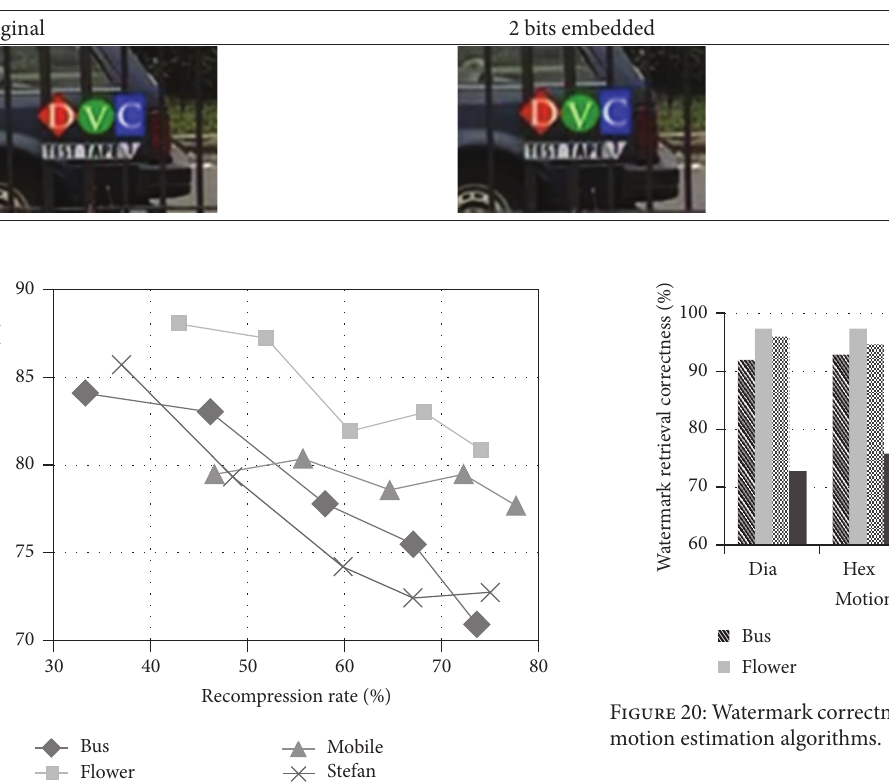
Table 8: Comparison of different watermark capacities.